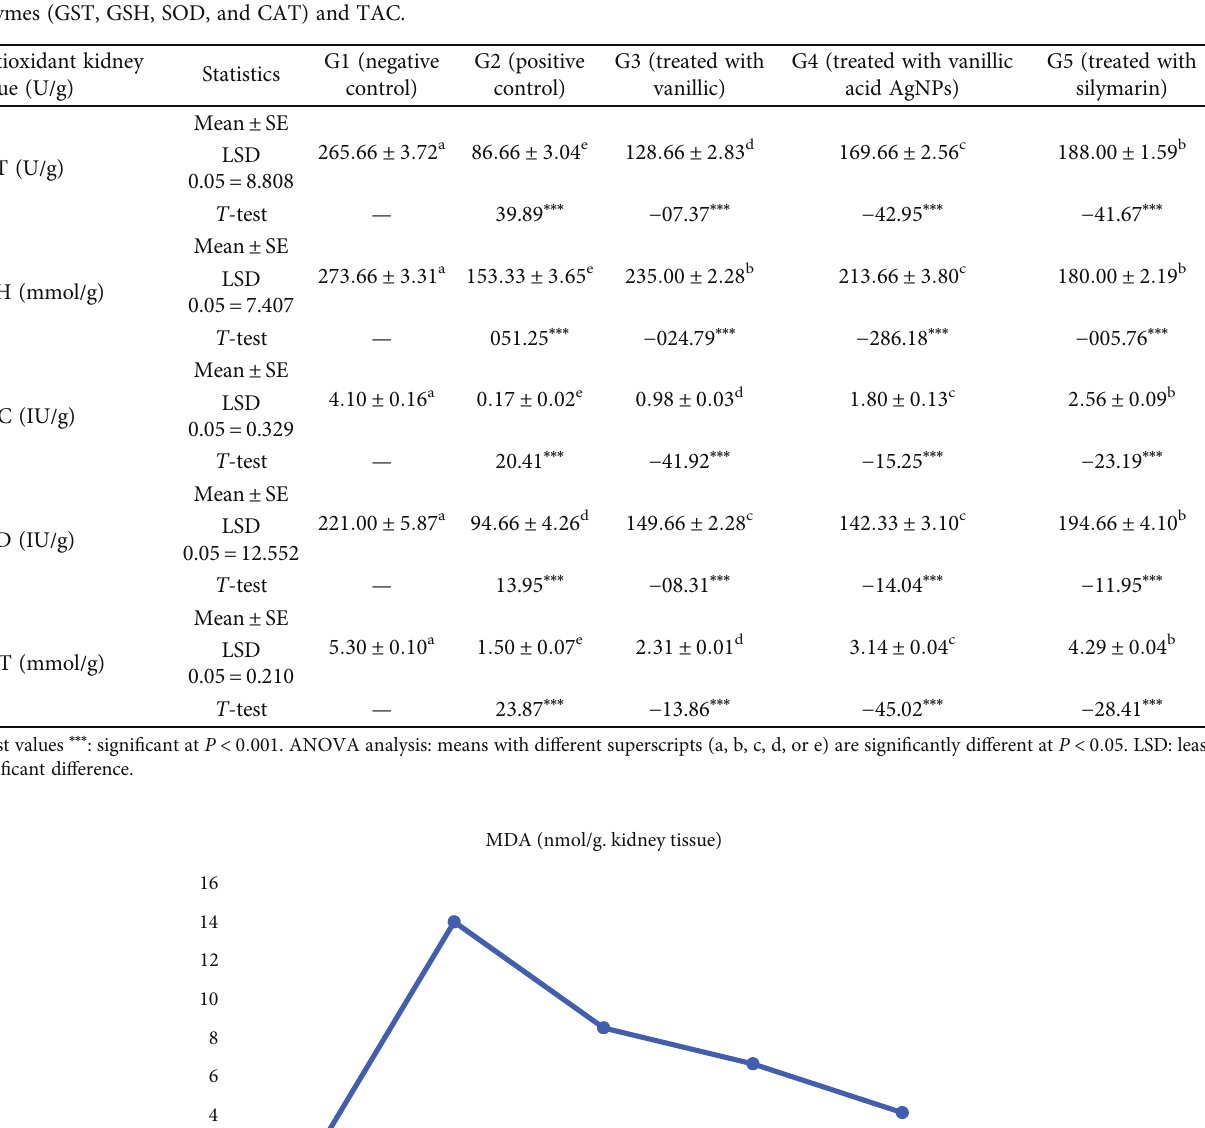
Table 2: E ff ect of treating CCl -induced nephrotoxicity in male rats with vanillic acid, vanillic acid AgNPs, and silymarin on antioxidant 4 enzymes (GST, GSH, SOD, and CAT) and TAC.